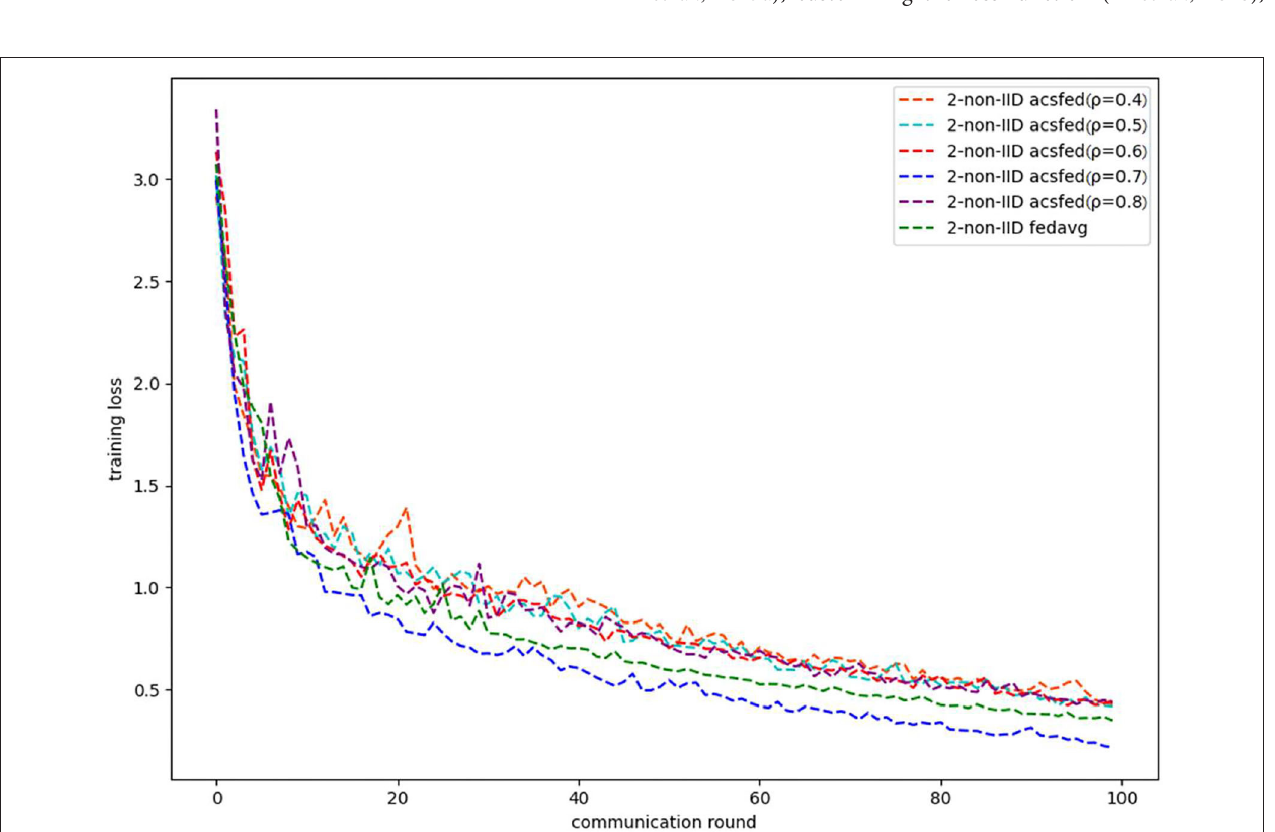
FIGURE 1 | Training loss on MNIST in 2-class non-IID